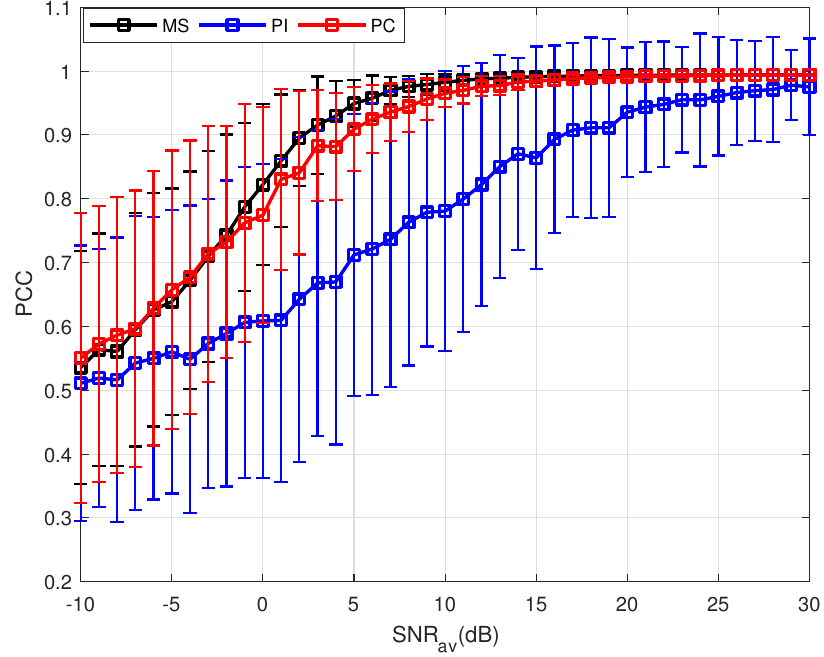
Figure 5. Results of three PSM estimation methods where P = 500.